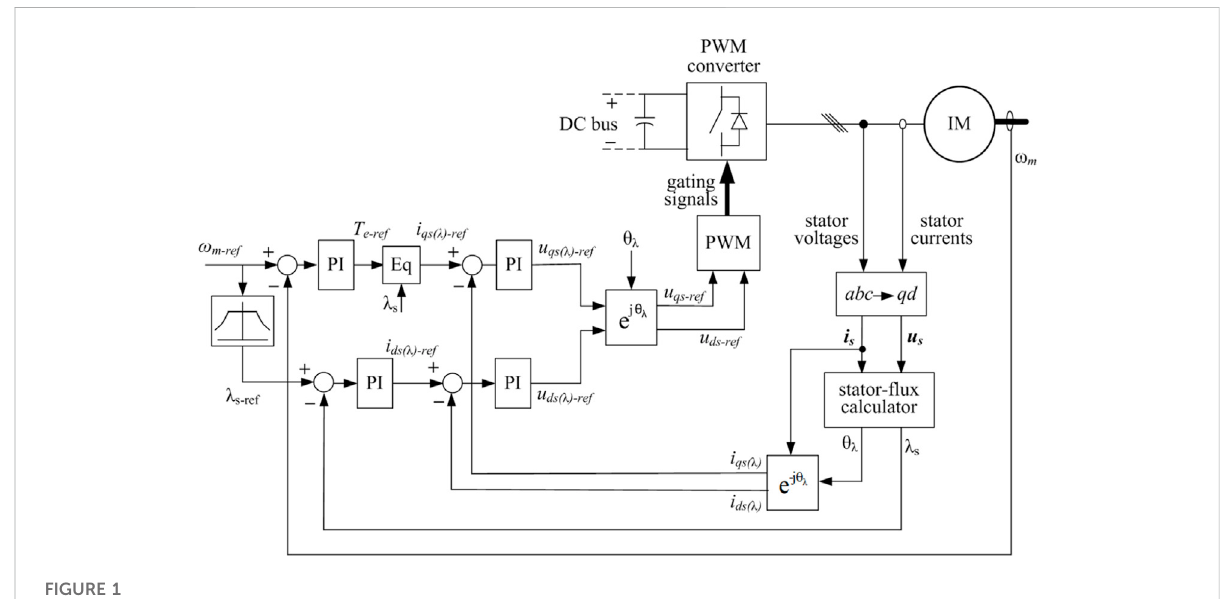
FIGURE 1 Typical DSFOC